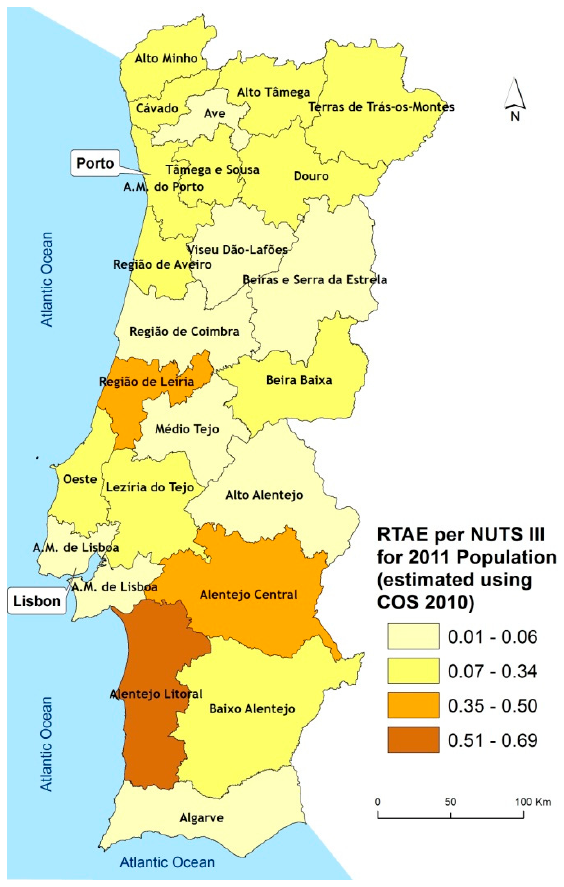
Figure 2. Validation results of the Population grid map produced for 2011 by NUTS III regions, expressed as Relative Total Absolute Error (RTAE).